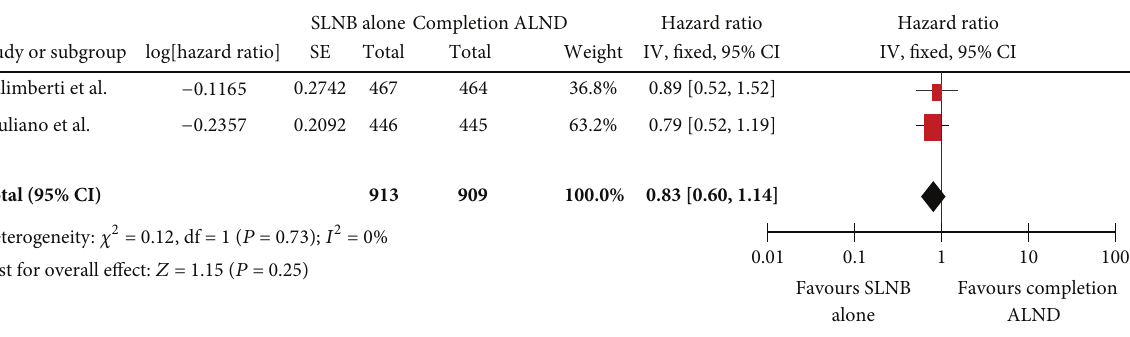
Figure 2: Forest plot showing pooled effect of overall survival in SLNB alone versus completion ALND in SLN positive breast cancer patients.